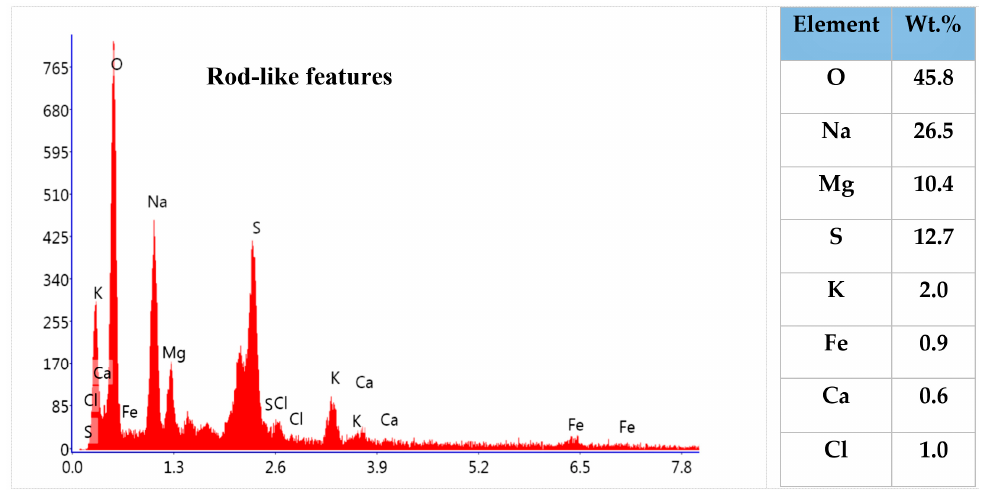
Figure 13. An EDS analysis of area shown in Figure 12 ( x -axis: Energy (KeV), y -axis: a.u.). The corroded tube was also cultivated in the media. The results revealed that due to reactivation and reproduction of SRB, the amount of corrosion products increased. The corrosive effects of SRB are shown in Figure 14. The redox potentials of as-received soil before inoculation in an SRB-specific medium and that after inoculation were 19 and − 315 mV, respectively. The decrease in the redox potential can be attributed to the enhanced activity of SRB, which is in accordance with the presented results of Figures 11–13 [23,24].